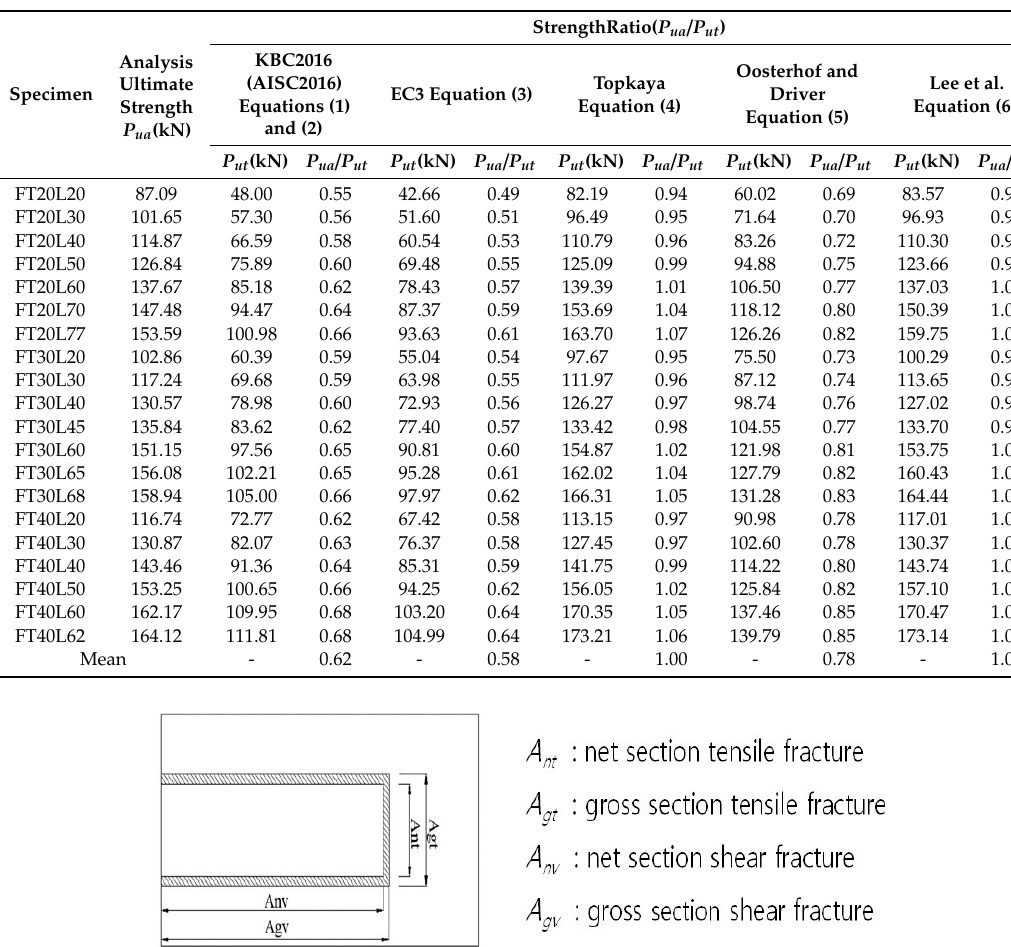
Table 5. Strength comparison of analysis result and design prediction.